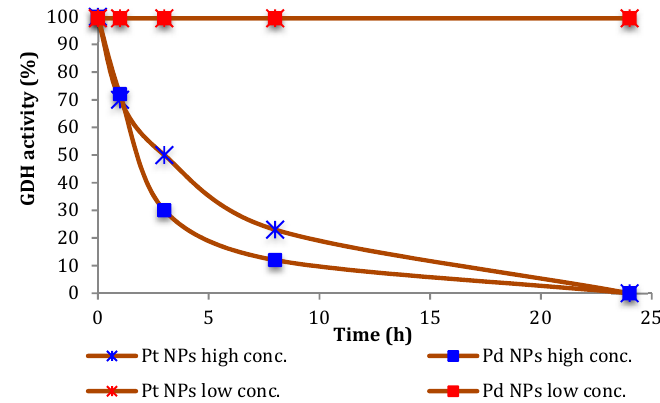
Figure 1. GDH activity over time in the presence of Pt and Pd NPs, at different NPs concentrations. (NPs low conc.: 10 μ L of 5.64 × 10 − 3 M Pd NPs or 5 μ L of 9.66 × 10 − 3 M Pt NPs, with 4 mg of GDH similar to the same ratio used in the reaction carried out in autoclave; NPs high conc.: 100 μ L of 5.64 × 10 − 3 M Pd NPs or 50 μ L of 9.66 × 10 − 3 M Pt NPs, with 4 mg of GDH) (see experimental).